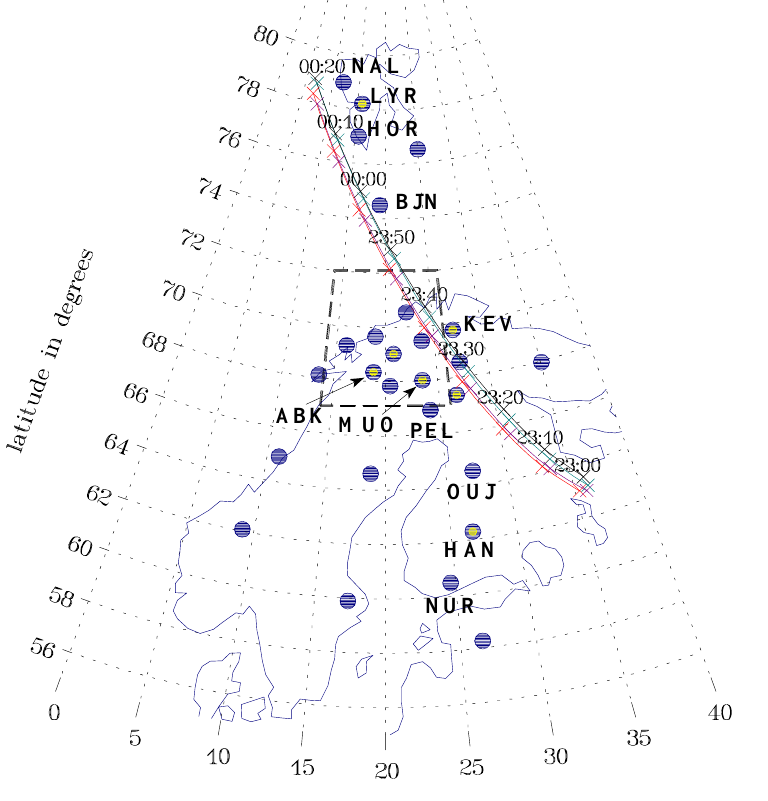
Fig. 1. The MIRACLE network in Scandinavia and Svalbard, and the mag- netic footprints of the Cluster II satel- lites during from 6 February 2001, 23:00–00:20 UT. Blue dots: IMAGE magnetometer stations; blue dots with yellow inner dots: IMAGE magnetome- ter station and all-sky camera station: dashed rectangle: field of view of the STARE coherent scatter radar; colours of the Cluster II footprint paths: black: spacecraft 1; red: spacecraft 2; green: spacecraft 3; cyan: spacecraft